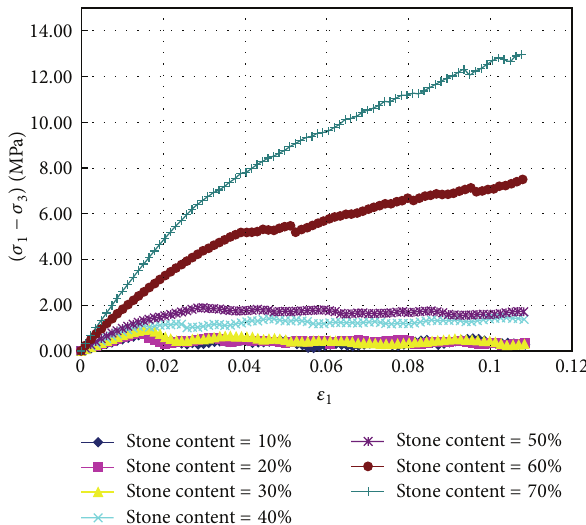
Figure 16: The biaxial compression curve with different stone block